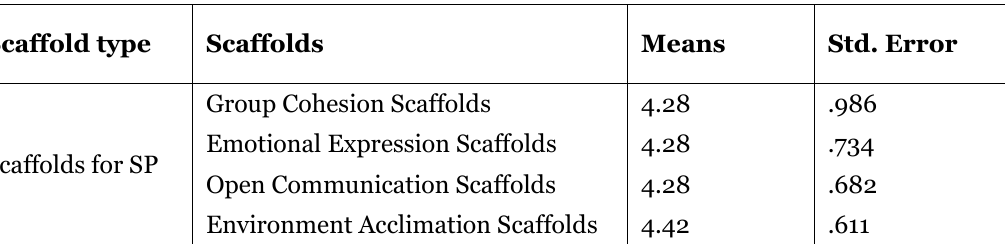
Survey Results on Effectiveness of Scaffolds for Social Presence